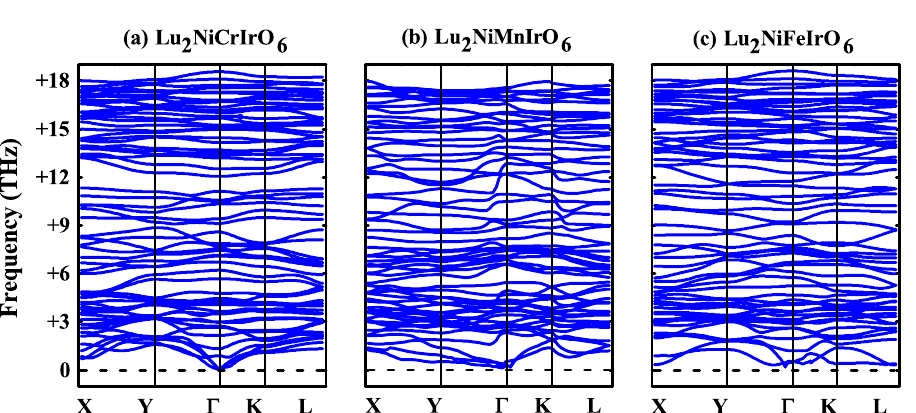
Figure 2. Calculated phonon dispersion band structures for ( a ) Cr-, ( b ) Mn-, and ( c ) Fe-doped Lu 2 NiIrO 6 double perovskite